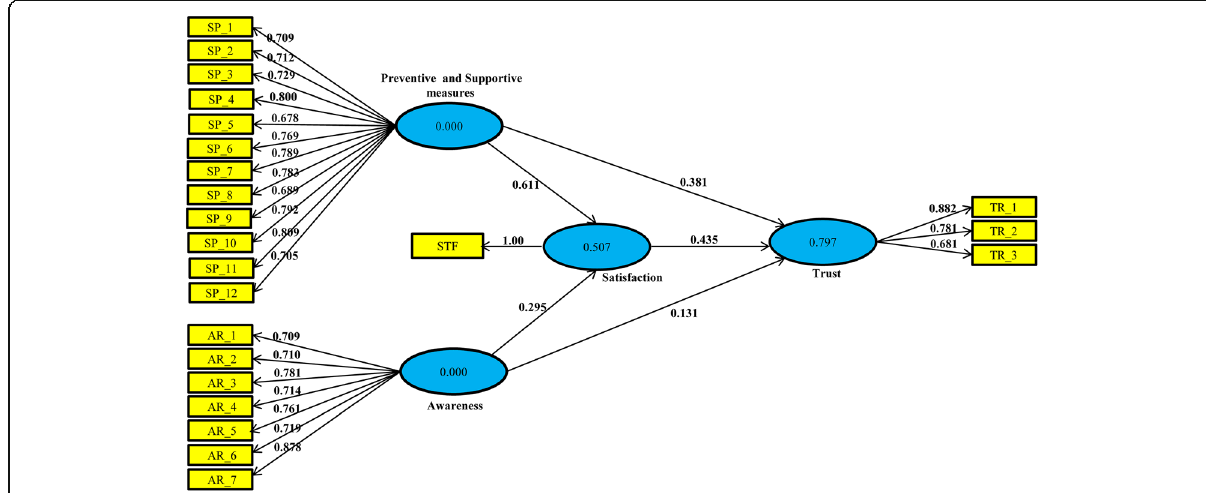
Fig. 2 A structural model for PLS-SEM hypothesis tests